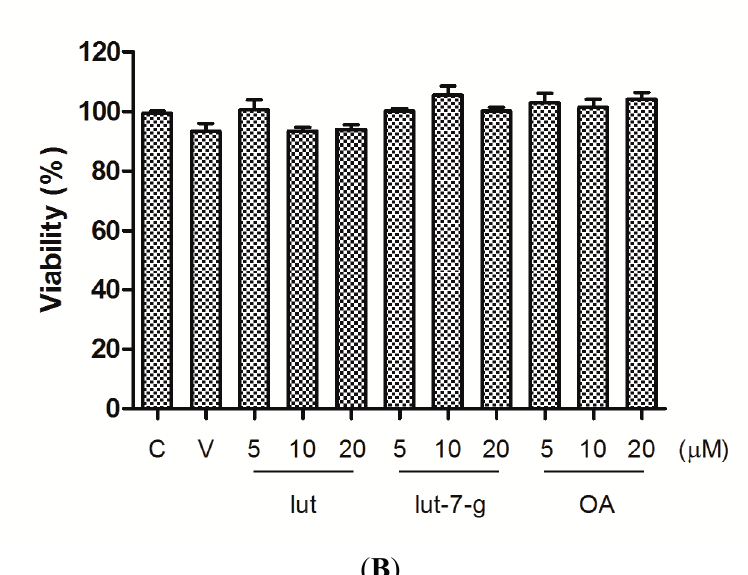
Figure 1. Effect of GTE, lut, lut-7-g, and OA on cell viability. MTT assay was performed to assess the cytotoxicity of GTE, lut, lut-7-g, and OA on HUVECs. HUVECs were treated with medium only (Control, denotes as “C”), vehicle only (DMSO, 0.25% for GTE group and 0.1% for pure compounds group; denotes as “V”), GTE (40, 80, 120, 160 μ g/mL), lut (5, 10, 20 μ M), lut-7-g (5, 10, 20 μ M), and OA (5, 10, 20 μ M) for 24 h. The cell viability was not affected after incubation for 24 h with, ( A ) GTE at concentrations up to 160 μ g/mL; and ( B ) lut, lut-7-g, and OA at concentrations up to 20 μ